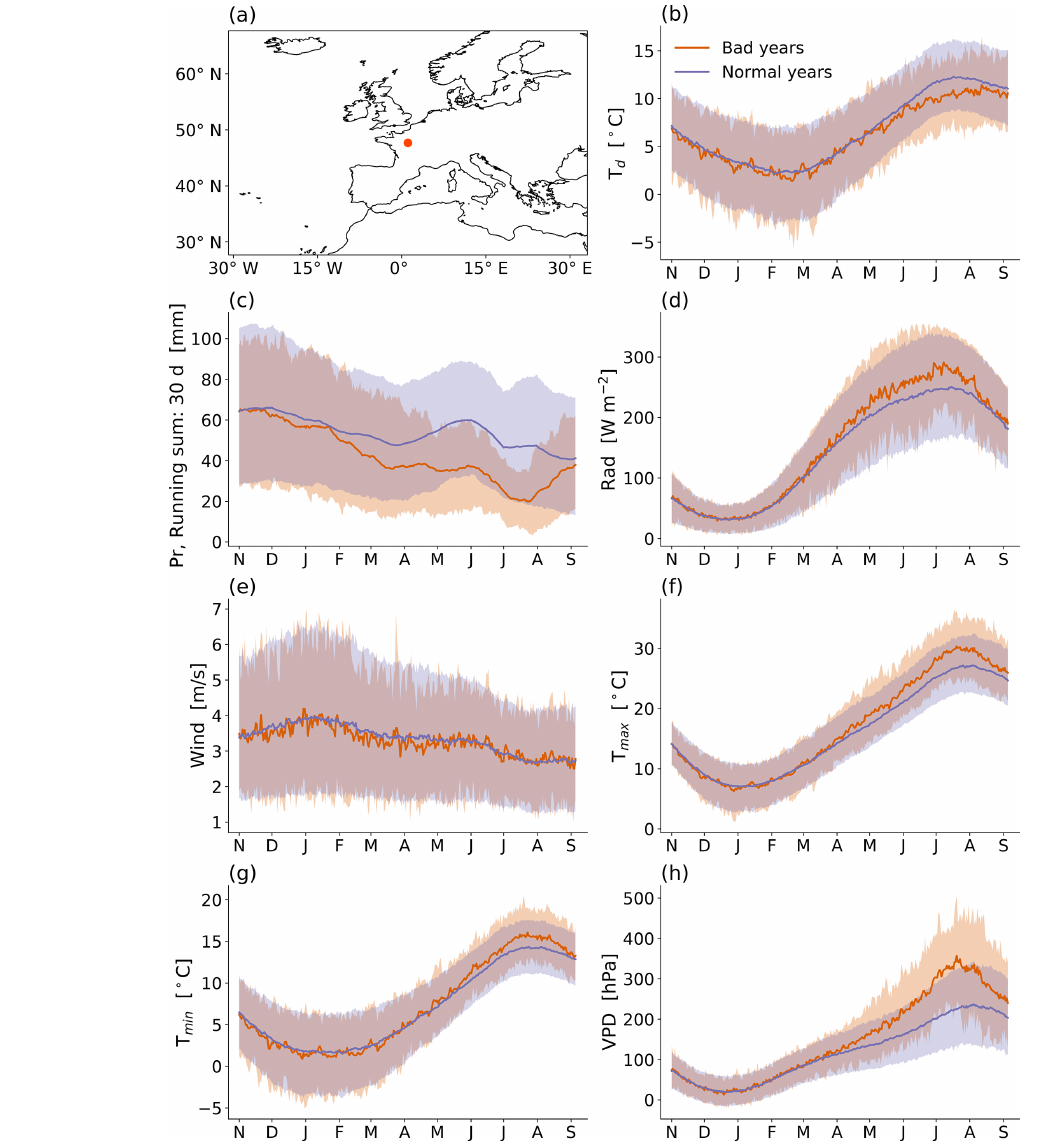
Figure 2. Daily evolution of meteorological variables used as input for the APSIM model over the course of the year for an exemplary grid point in France (47.7 ◦ N, 1.1 ◦ E; shown as a red dot in panel a ). Red lines indicate the composite mean of the bad years (80 seasons); blue lines indicate the composite mean of the normal years (1520 seasons). Shading shows the range between the 10th and 90th percentiles of the respective years. Variables shown are (b) dew-point temperature, (c) 30d running sum of precipitation, (d) incoming shortwave radiation, (e) wind speed, (f) maximum temperature, (g) minimum temperature and (h) vapour pressure